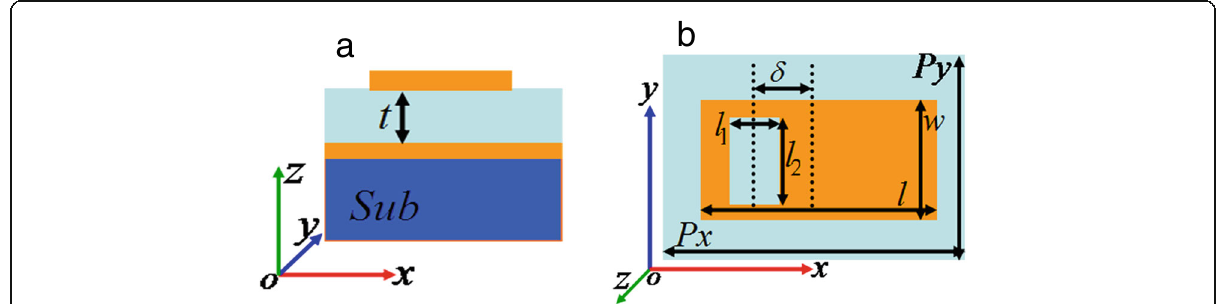
Fig. 1 a and b are respectively the side- and top view of the presented quad-band terahertz metamaterial